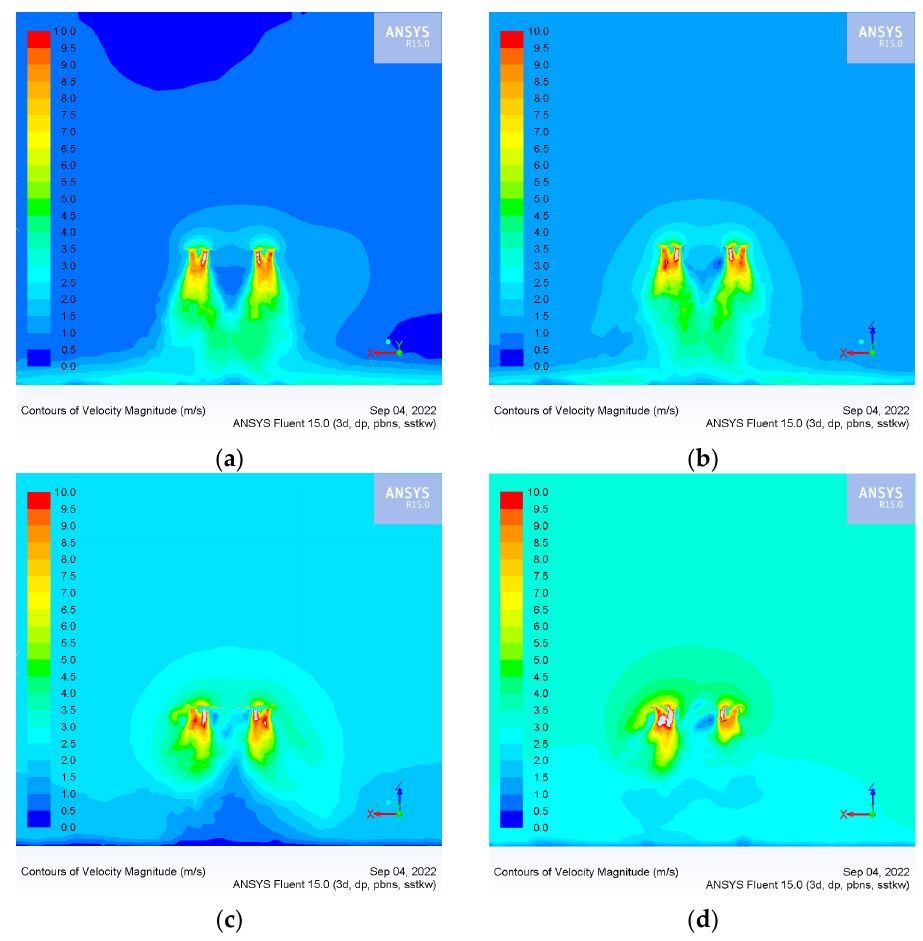
Figure 10. Wind speed field distribution of the xoz section with a flight height of 3 m, crosswind speed of 0 m/s, and different flight speeds: ( a ) UAV flight speed of 0.5 m/s; ( b ) UAV flight speed of 1 m/s; ( c ) UAV flight speed of 2 m/s; and ( d ) UAV flight speed of 3 m/s.